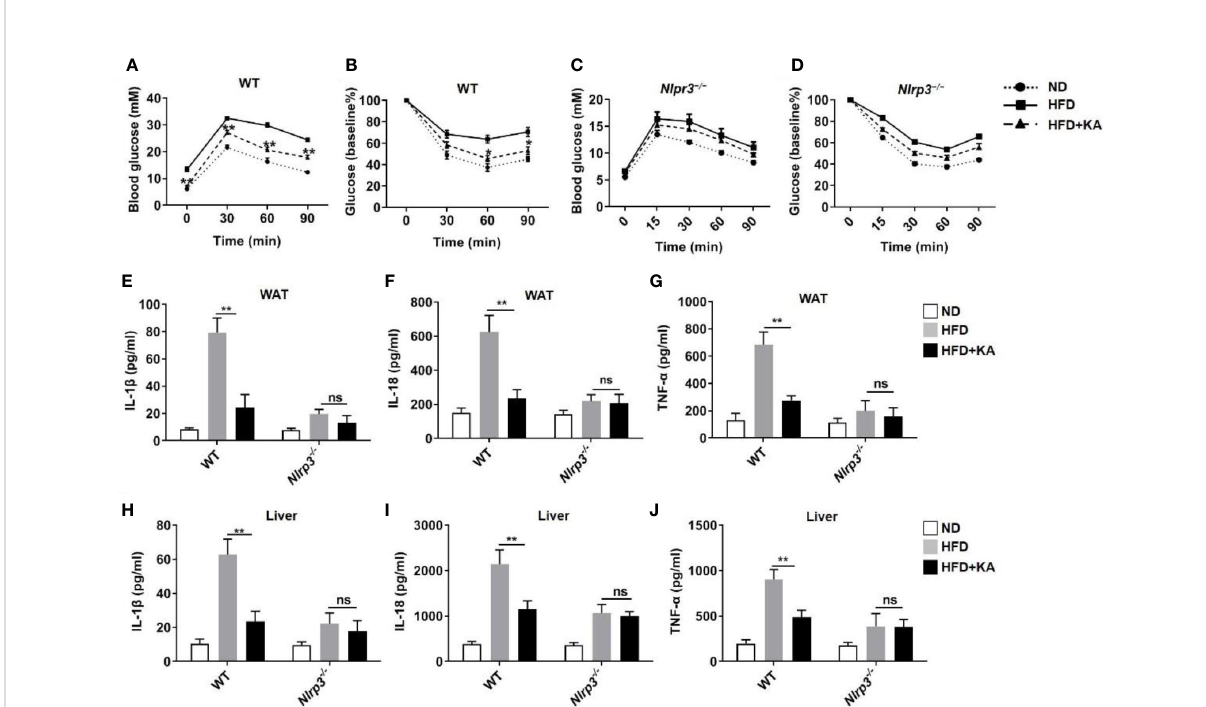
FIGURE 6 KA mitigates NLRP3 in fl ammasome-mediated metabolic disorder. Mice were fed a normal diet (ND) or a high-fat diet (HFD) for 14 weeks. Mice at 8 weeks of HFD feeding were treated with KA at a dose of 50 mg·kg – 1 by oral administration every other day or an equal volume of saline for 6 weeks. (A, B) Glucose tolerance (A) and insulin tolerance (B) were tested in WT mice. (C, D) Glucose tolerance (C) and insulin tolerance (D) were tested in Nlrp3 − / − mice. (E-G) Adipose tissue (WAT) was isolated and cultured for 24 hours, and supernatants were analysed by ELISA for the release of IL-1 b (E) , IL-18 (F) , and TNF- a (G) . (H, I) The livers were isolated and cultured for 24 hours, and the supernatants were analysed by ELISA for the release of IL-1 b (H) , IL-18 (I) , and TNF- a (J) . Data are representative of three independent experiments and show as the mean ± SEM. Statistical signi fi cance was analysed by the nonparametric Mann − Whitney test: p < 0.05, **p < 0.01; ns, no signi fi